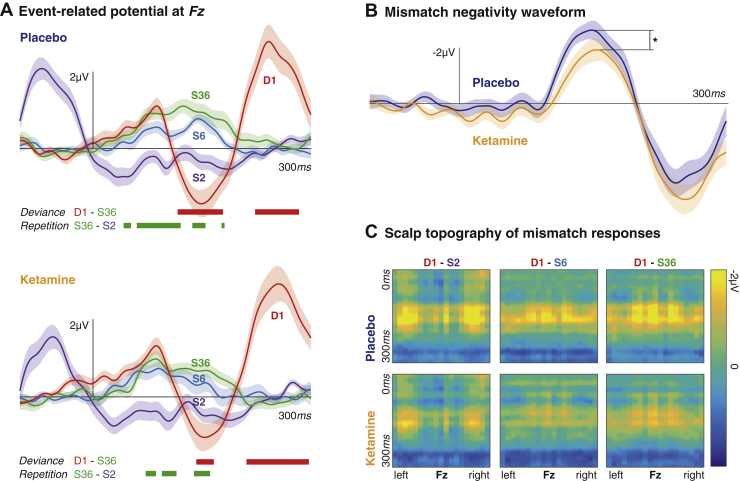
Ketamine causes a reduction in the mismatch negativity. (A) Event-related potentials are shown for repetitions of a sound within a roving oddball paradigm. The first exposure to a sound within a sequence (D1) provokes a typical deviance response at the Fz electrode. Event-related potentials for three different repetitions (S2, S6, and S36) show increasing positivity with a peak at approximately 120 ms. The bold red lines indicate time points for which the S36 and D1 event-related potentials are significantly different across the group (i.e., the effect of deviance; p < .05, Bonferroni corrected for multiple comparisons); the bold green lines indicate time points for which S36 and S2 are significantly different (i.e., the effect of repetition; p < .05, Bonferroni corrected for multiple comparisons, differences only tested for the 0- to 300-ms peristimulus time interval). Ketamine reduces both the deviance and repetition effects. (B) Difference waveforms at Fz are shown for D1 to S36. The peak amplitude of the waveform around 150 ms is significantly larger for the placebo condition compared with the ketamine condition (indicated by the asterisk). (C) The panels show the difference between D1 and S2, S6, and S36, respectively, across time (y-axis) and channels (x-axis, arranged from left to right). For each standard-deviant pair, there is a ketamine-related reduction in mismatch responses.